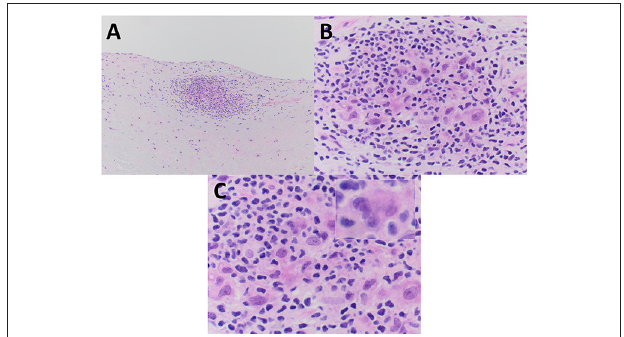
FIGURE 2 | The excised mitral valve of Patient #2 showed a small focus of non-necrotizing granulomatous inflammation, adjacent to the valve surface, and less well-formed as that seen in Patient #1. (A–C) Mononuclear inflammatory cells morphologically consistent with lymphocytes surround and partially admix with epithelioid histiocytes and a rare multinucleated giant cell. (C inset) All images are from hematoxylin and eosin stained paraffin sections. Original magnification for A at × 100; for B at × 400; and for C and C inset at ×